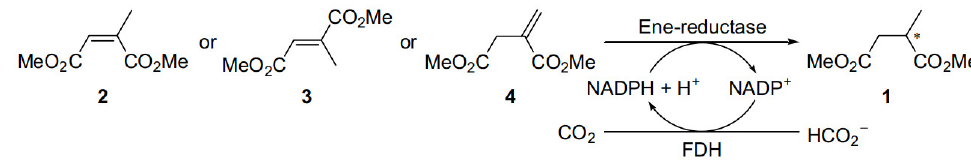
Figure 2. The synthetic strategy towards chiral dimethyl 2-methylsuccinate ( 1 ) in this study. Asterisk (*) indicates a chiral center.